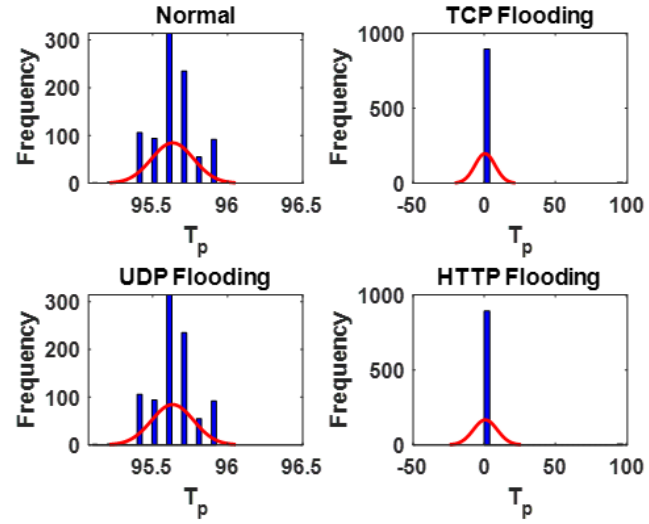
Figure 4. The distributions of T p metrics for various SDN scenarios.